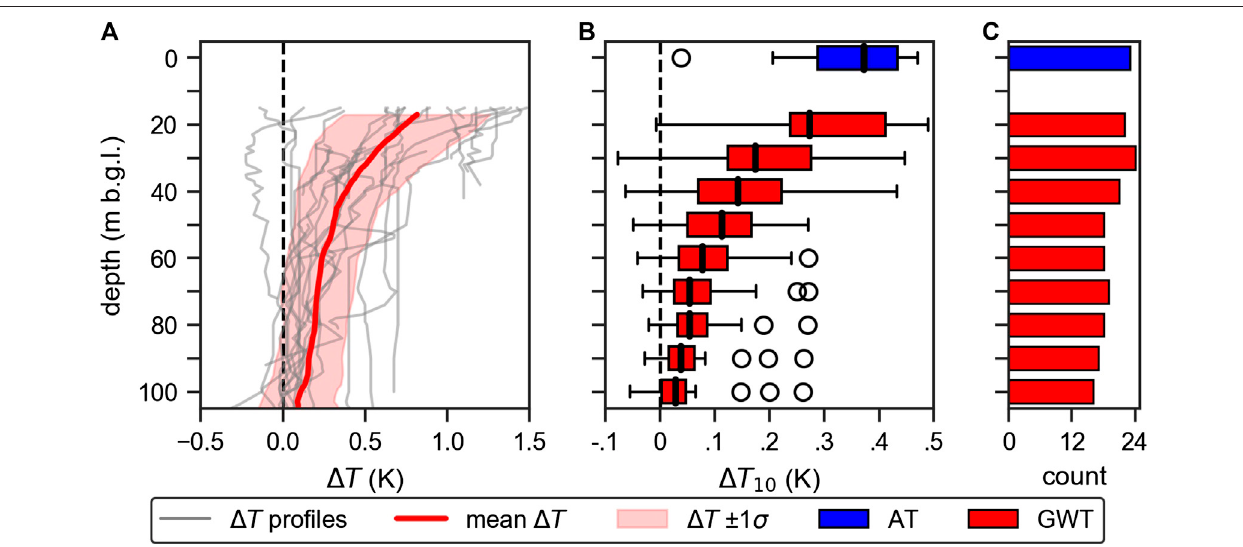
FIGURE 2 | (A) Differences ( Δ T) between the temperature pro fi les measured in 2019 vs. the mean signal of the time period from 1992 to 1994 (gray lines). The arithmetic mean difference (red line) is calculated as rolling mean with a window of 5 m and is displayed as red line along with the standard deviation (1 σ ) as red transparent area. (B) Decadal temperature change rate ( Δ T 10 ) for air temperature (AT, blue box) and groundwater temperature at different depths (GWT, red boxes). AT represent the slopes of ordinary least squared regression on annual mean values from 1990 to 2018. GWT rates are calculated from temperature-depth pro fi les measured in 2019 and 1992 – 1994. Whiskers are drawn for values smaller than 1.5 magnitudes of the interquartile range. Outliers are shown as dots. (C) Count of measurements at respective